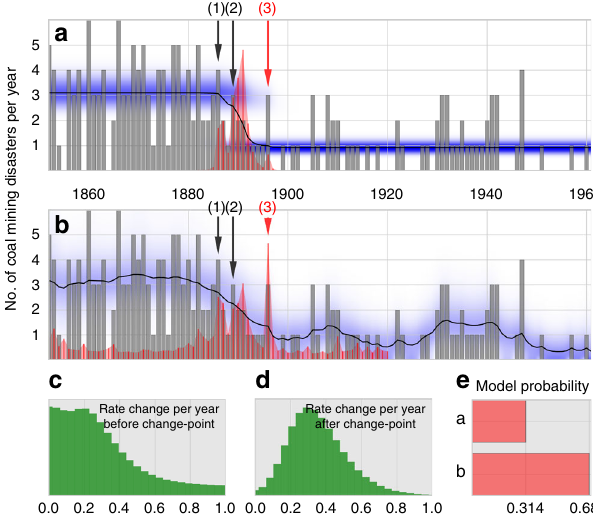
Fig. 2 Frequency of mining accidents. a Reported annual number of accidents (gray bars) and inferred mean accident rate (black line), based on a classic change-point model. Blue shading indicates the distribution of the accident rate. Red bars indicate the inferred change-point distribution. Arrows indicate relevant historical events. (1) Safety report of a Royal Commission, (2) Foundation of the Miner ’ s Federation, (3) Enactment of safety regulations. b Same as in a for the alternative model with additional Gaussian fl uctuations of the accident rate. c , d Distributions of the magnitude of accident-rate fl uctuations (standard deviation) before c and after d the change-point, for the alternative model shown in b . e Relative model evidence values of the classic a versus the alternative b change-point